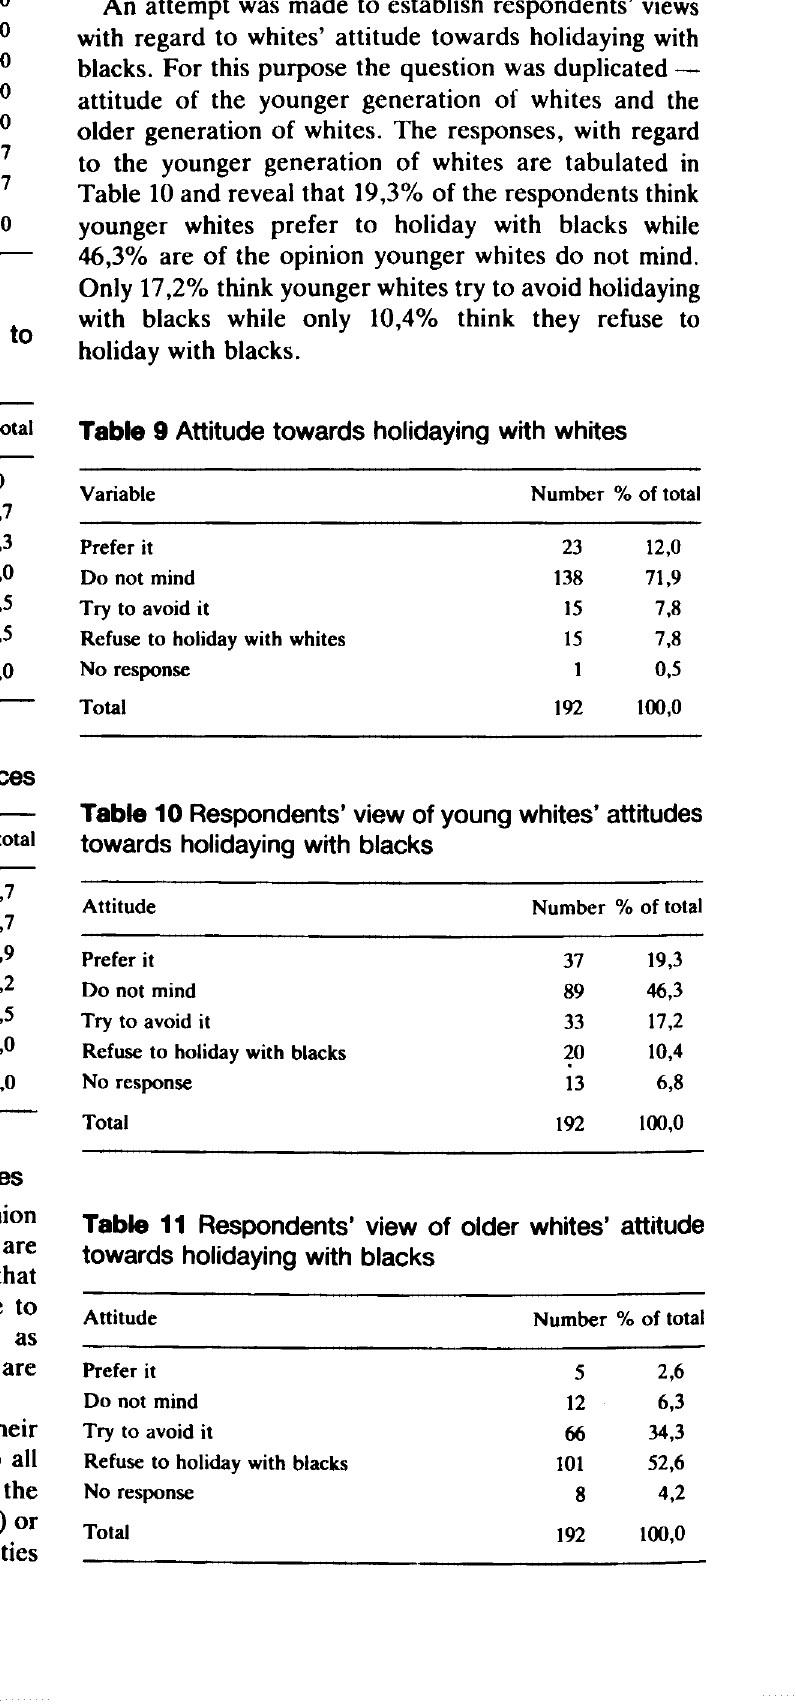
Table 7 Evaluation of holiday facilities available to blacks only